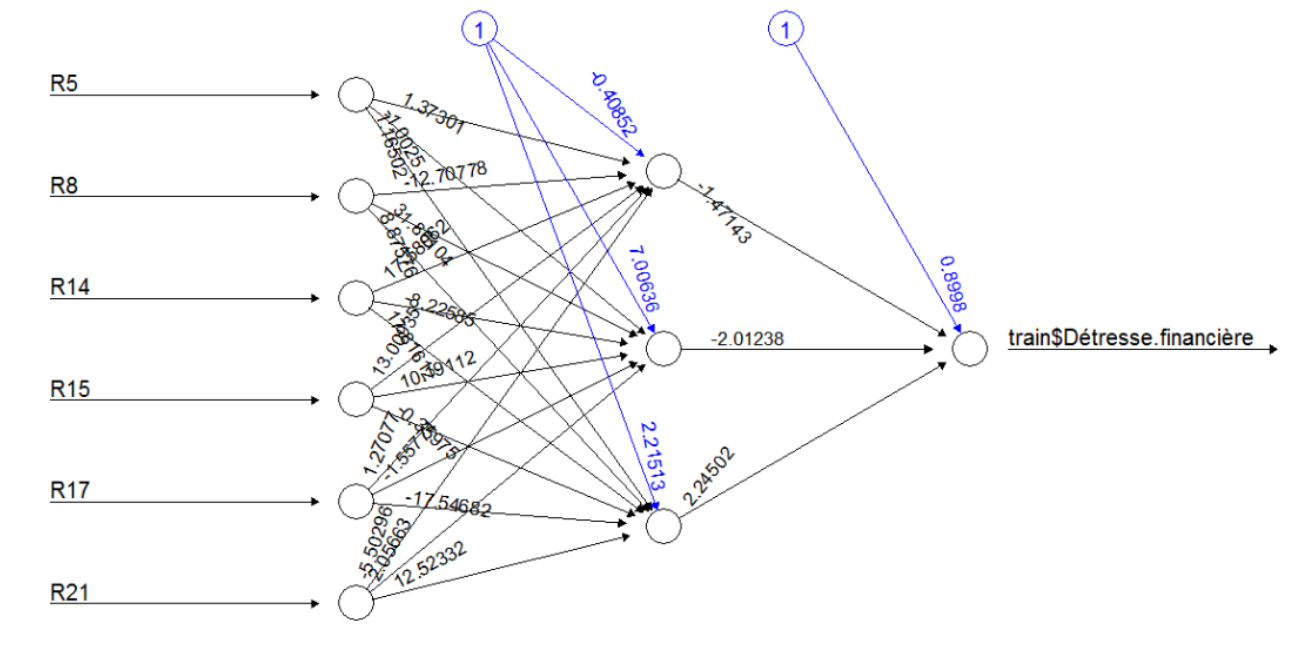
Figure A2. Neural networks model for stepwise selection technique, year 2018.